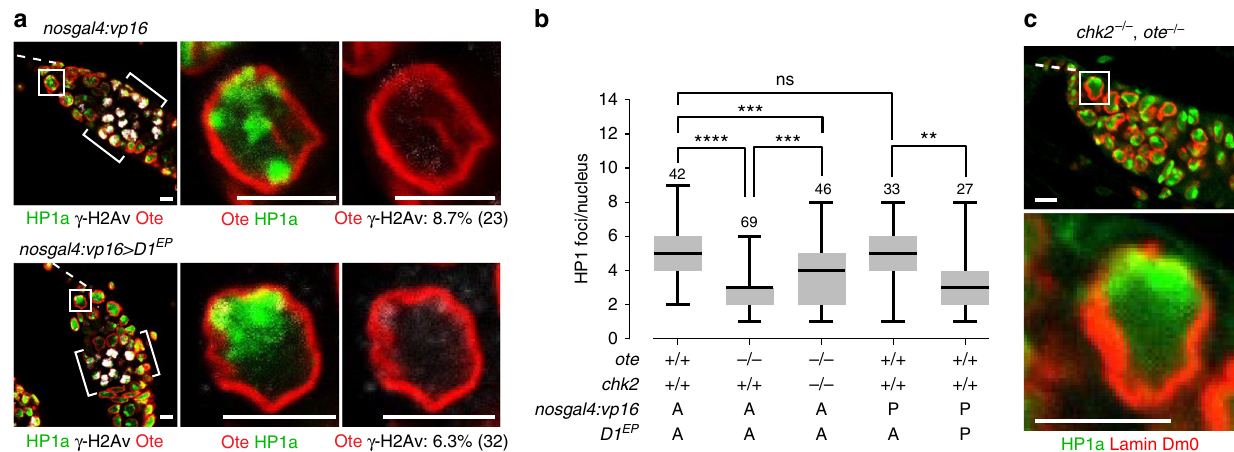
Fig. 6 HP1a coalescence does not lead to increased γ H2Av staining or GSC loss. a Confocal images of germaria and GSC nuclei in females carrying either the nosgal4:vp16 driver alone (top) or the nosgal4:vp16 and the D1 EP473 allele (bottom). Ovaries were stained with antibodies against HP1a (green), γ -H2Av (white), and Ote (red). The percentage of γ -H2Av-positive GSCs is noted at the bottom of the GSC image, with the number of GSCs analyzed in parenthesis. Scale bars represent 5 μ m. b Box plots of the quanti fi cation of HP1a foci per GSC nucleus found in GSCs of the indicated genotype. Genotypes are noted below each box plot, and the number of nuclei analyzed is noted above each top whisker. An A indicates absence of the nosgal4:vp16 driver or the D1 EP allele, and P indicates their presence. For each box plot, the box represents the 25th to 75th percentile interval, the line represents the median and the whiskers represent the 5th to 95th percentile interval and non-outlier range. Asterisks indicate signi fi cance (one-way ANOVA, ns = not signi fi cant, **<0.01, ***<0.001, ****<0.0001). c Confocal images of a GSC nucleus from 1-day-old chk2 − / − , ote − / − females stained for Lamin Dm0 (red) and HP1a (green), revealing that nuclear structural defects are upstream of Chk2. Genotypes are listed above each image. The chk2 − / − corresponds to chk2 P6 / chk2 P30 and ote − / − corresponds to ote B279G/PK . The box outlines GSCs. Scale bars represent 5 μ